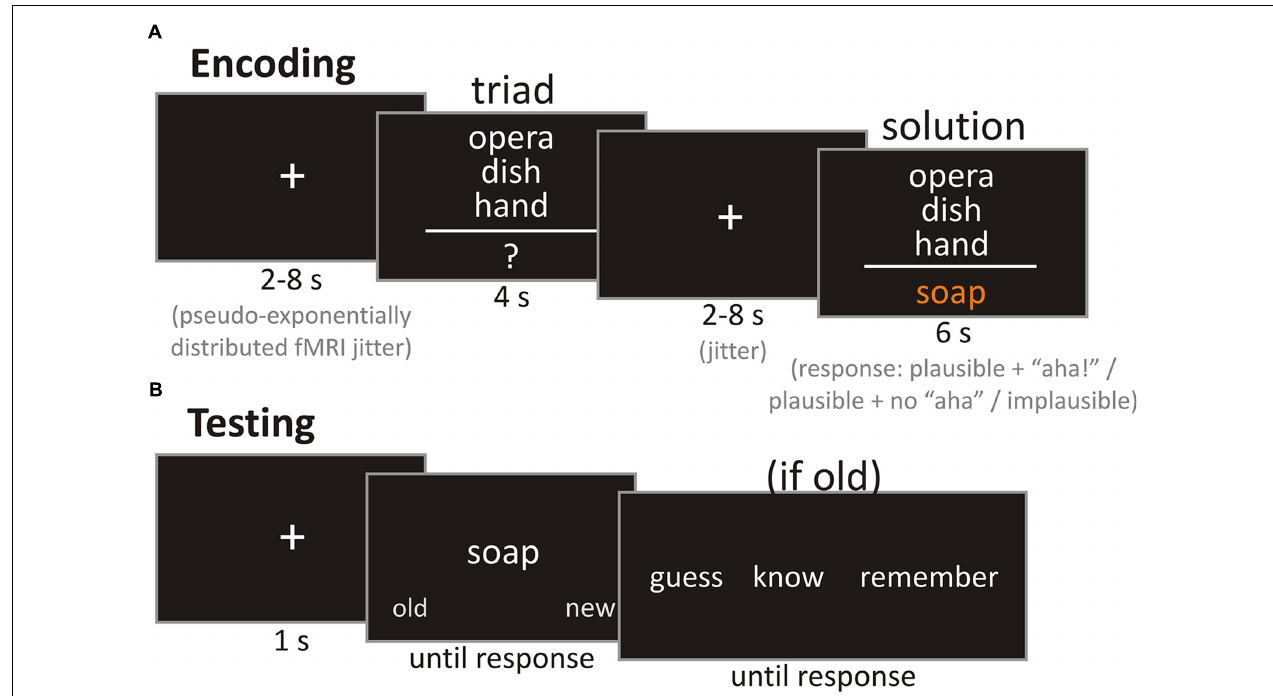
FIGURE 1 | Example trials of the encoding and test phases. (A) Exemplary trial of the encoding phase. Participants were asked to press a button depending on whether they thought the solution was plausible while experiencing an “aha!,” plausible without experiencing an “aha!,” or implausible during the presentation of the solution. (B) Exemplary trial of the test phase. Participants were asked to decide whether a presented solution was old or new. If an item was judged as old, participants should further differentiate between know and remember, or, if not sure about the solution being old after all, guess.